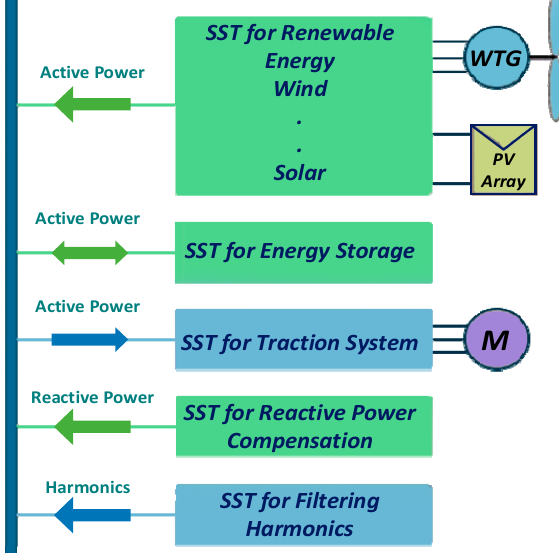
Figure 6. The numerous applications of SST